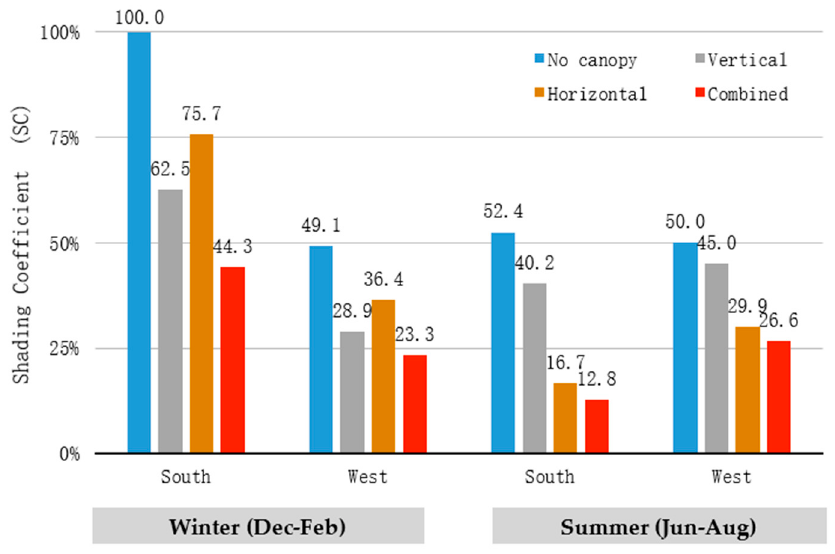
Figure 7. Shading coefficient in winter and summer.